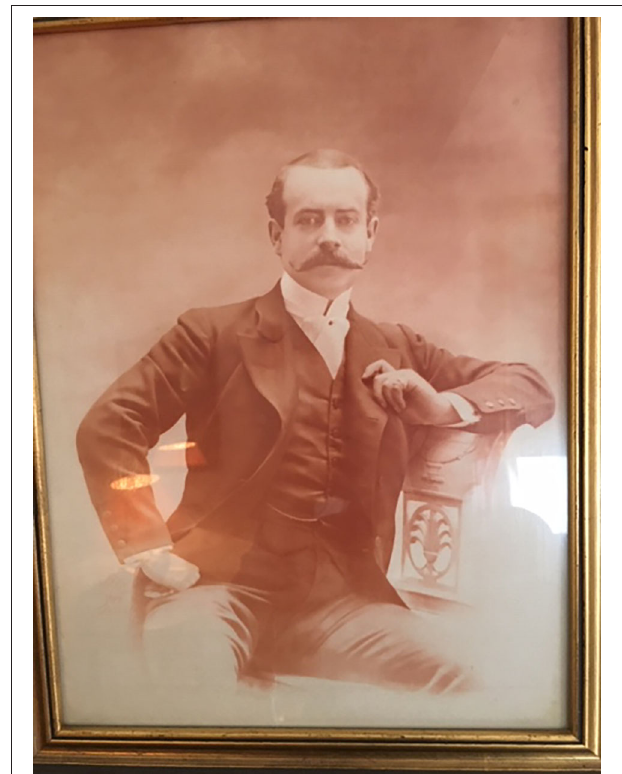
FIGURE 1 | Portrait of Alfred Swann, photo courtesy of Yvonne